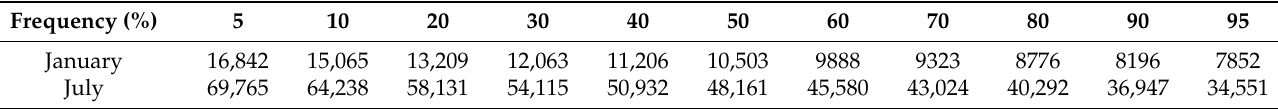
Table 1. Frequency analysis of river discharge at the Datong hydrologic station in January and July (unit of river discharge, m 3 /s). Frequency (%)